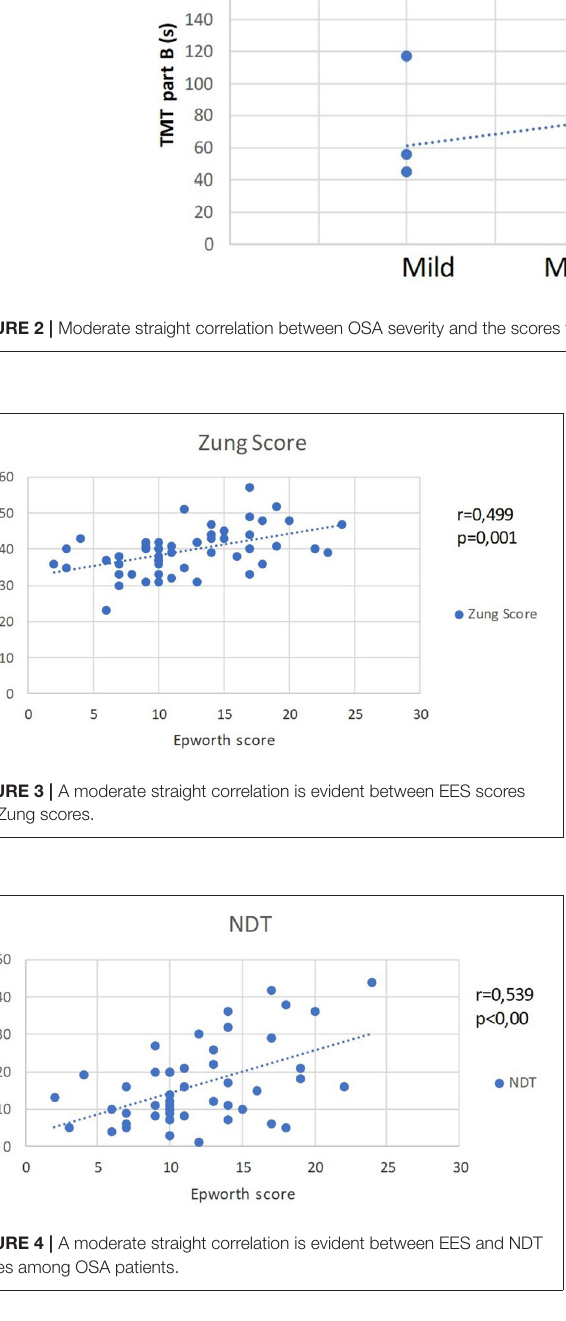
The relation between AHI and EES scores raises the question about the significance and causes of affective changes in patients with OSA. Additionally, melatonin is significantly involved in the regulation of the circadian sleep-wake